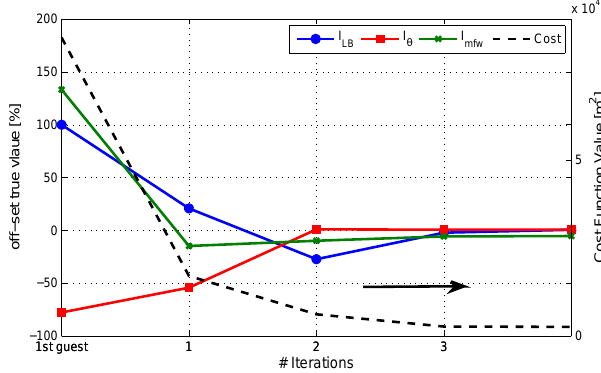
Figure 11. Convergence of cost function (black dashed line) and invariants (solid lines) when perturbed data are